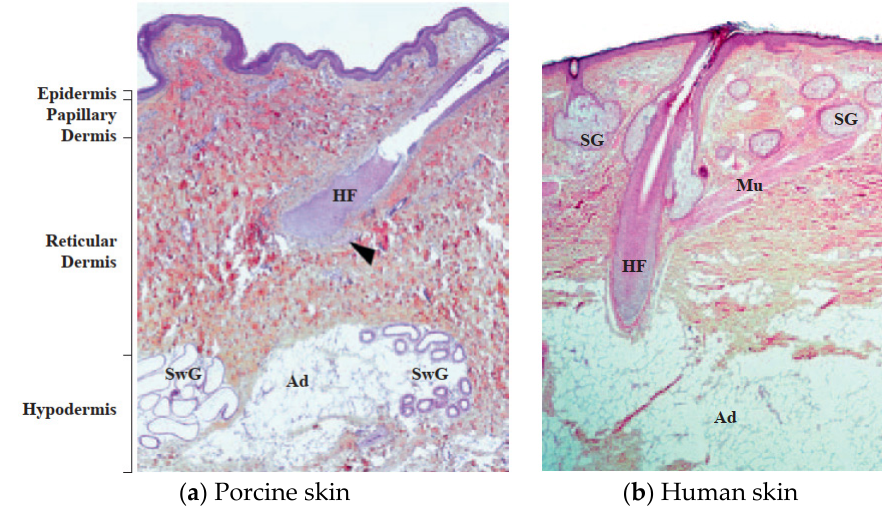
Figure 1. Comparative histological aspect of porcine ( a ) and human ( b ) skin (haematoxylin-eosin-saffron staining). HF: hair follicle, Mu and arrowhead: arrector pili muscle, SwG: Sweat gland, SG: sebaceous gland, and Ad: Adipocytes (hypodermis). Reproduced with permission from Debeer et al. [19] .